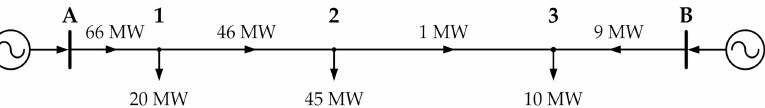
Figure 4. Active power flow in the analyzed network after considering the equalizing flow. Table 4. The degrees of individual branch utilization by all consumers, resulting from the power flow decomposition by the power flow tracing method–the equalizing flow considered. The Consumer